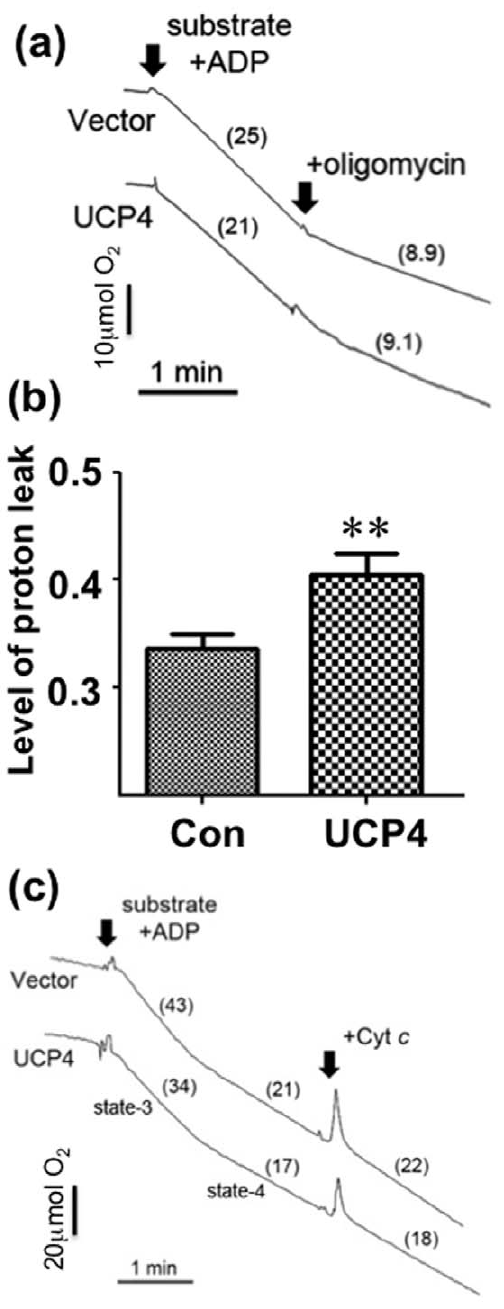
Figure 3. Level of proton leak and integrity of isolated mitochondria from UCP4-overexpressing and vector control cells. (a) Oxygraphs showing changes in dissolved oxygen in isolated mitochondria suspension from these cells under substrates-induced respiration. Maximum rate of oxygen consumption was recorded for 2 min after addition of substrates containing 5 mM glutamate & malate, 5 mM succinate, and 0.5 mM ADP. ATP synthase inhibitor, oligomycin (2.5 m g/ml) was then added to block ATP synthesis by Complex V. The rate of oxygen consumption with oligomycin was recorded for an additional 2 min, indicating Complex V-insensitive proton leak. Numbers in brackets represent the rate of oxygen consumption in m mol O 2 /min/mg mitochondrial protein. (b) The level of proton leak was defined as the ratio of the rate of oxygen consumption in the presence of oligomycin to the rate of substrates-stimulated oxygen consumption ( state 3 respiration). Results are expressed as mean ratios 6 SEM based on at least three independent trials. ** represents statistical